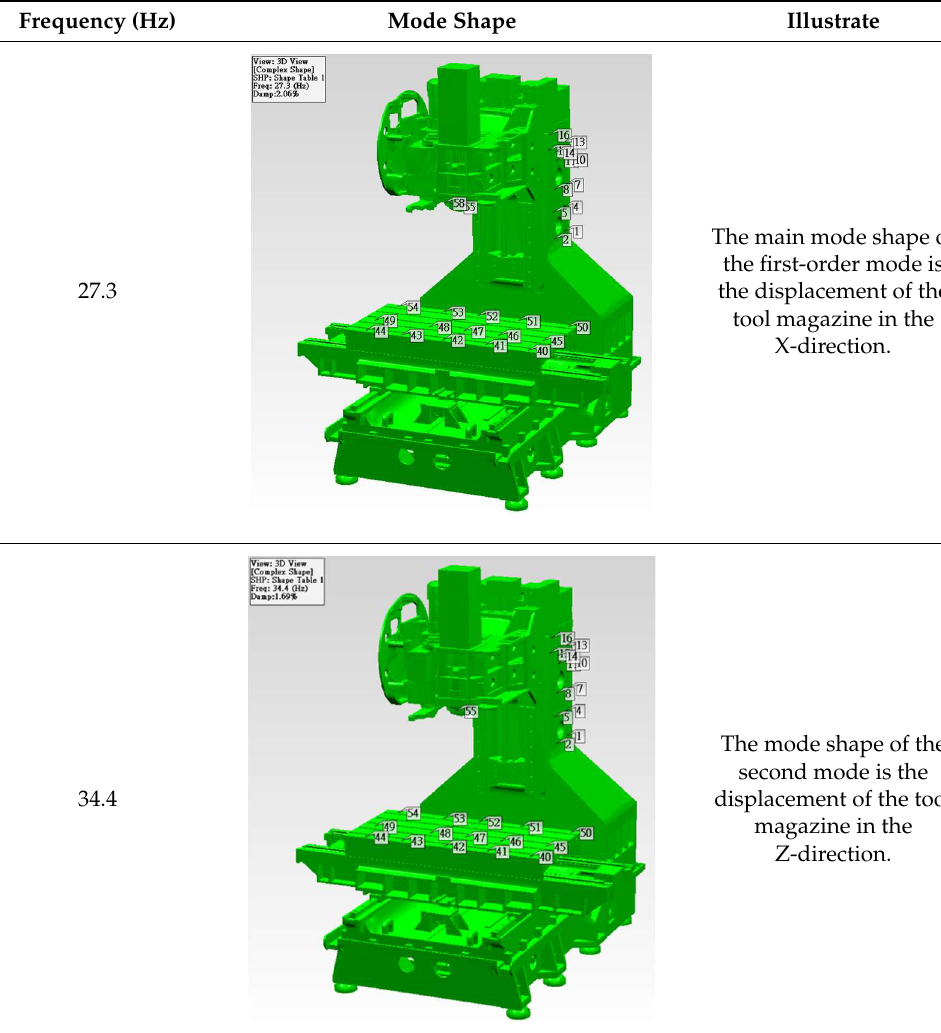
Table 8. Results of modal experiment.